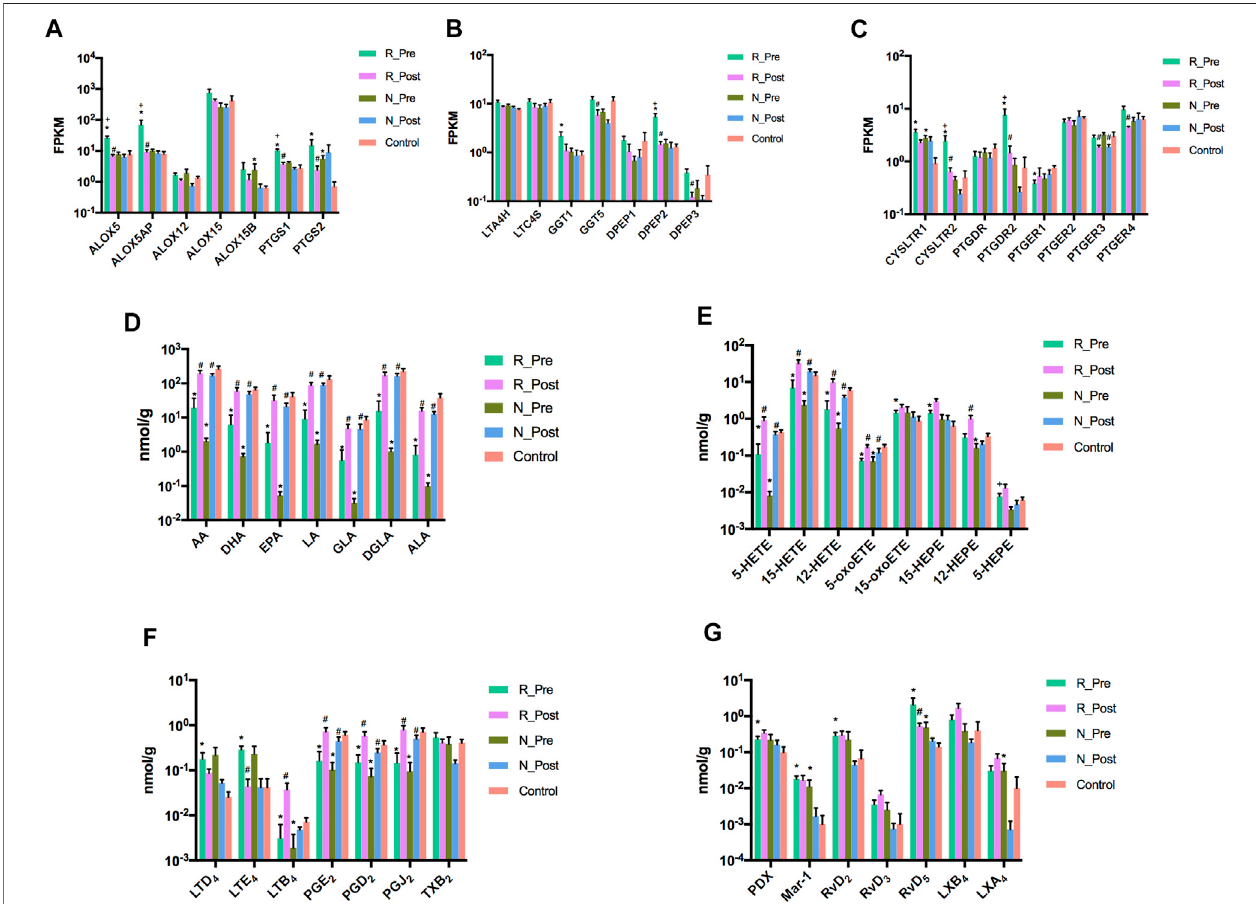
FIGURE 5 | Glucocorticoids ameliorate the dysregulation of lipid oxidative metabolism and signaling pathway in nasal polyps. The mRNA expression levels of lipoxygenases and cyclooxygenases (A) , other enzymes responsible for the synthesis of cysteinyl leukotrienes (B) and receptors for cysteinyl leukotrienes and prostaglandins (C) inR_Pre( n (cid:1) 9),R_Post( n (cid:1) 9),N_Pre( n (cid:1) 5),N_Post( n (cid:1) 5),andControl( n (cid:1) 5)groups.Amountsofvariousfattyacids (D) ,oxylipidsderivedfromAA andEPAthroughlipoxygenasepathway (E) ,cysteinylleukotrienes,prostaglandinsandthromboxane (F) ,andspecializedpro-resolvingmediators (G) inR_Pre( n (cid:1) 11), R_Post ( n (cid:1) 11), N_Pre ( n (cid:1) 5), N_Post ( n (cid:1) 5), and Control ( n (cid:1) 12) groups. * p < 0.05 compared to control, # p < 0.05 compared to baseline, + p < 0.05 compared to N_Pre. For comparison of the amounts of oxylipid mediators, Wilcoxon matched-pairs signed rank test and Mann-Whitney U test were used to compare two groups of paired and unpaired data. All data were expressed as mean ± standard error of the mean (SEM).